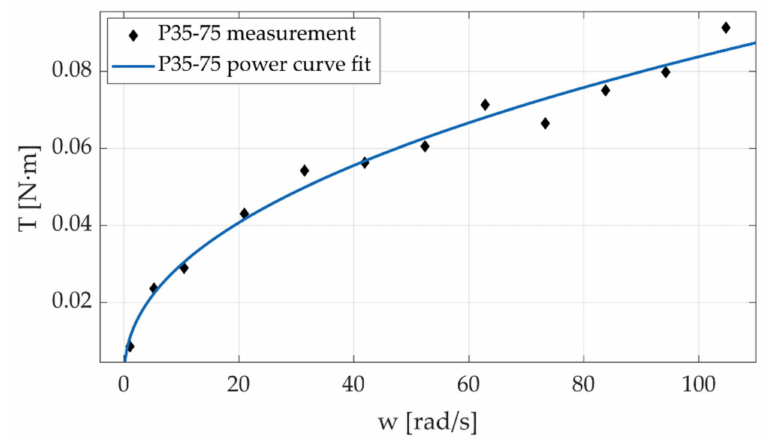
Figure 19. Friction torque of the cable-driven transmission 35–75 G.